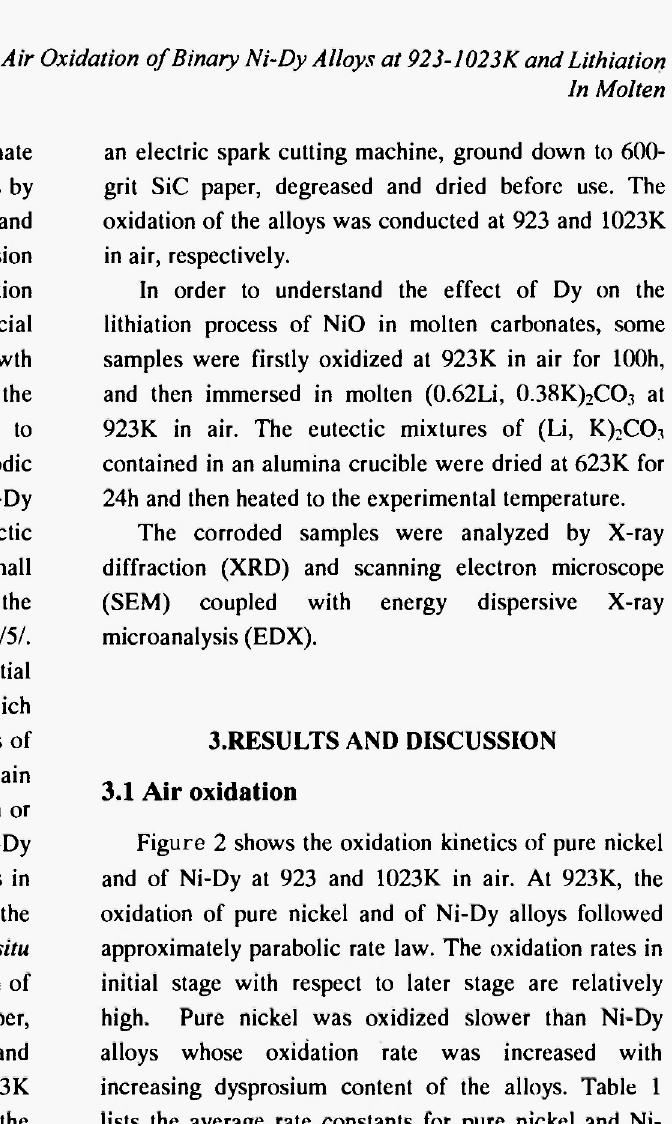
Average parabolic rate constants (g 2 m"V') for the oxidation of pure nickel and of Ni-Dy alloys at 923